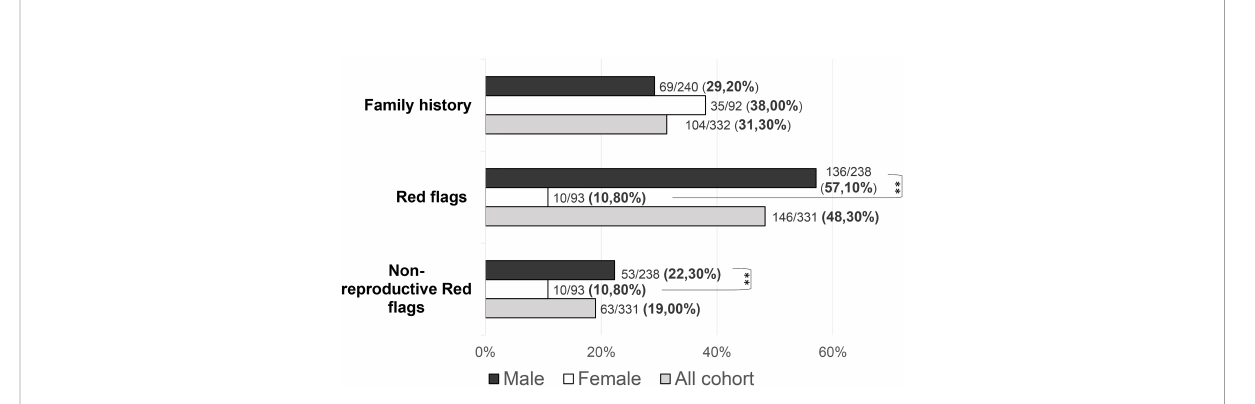
FIGURE 4 Prevalence of “ red fl ags ” and each “ non-reproductive ” defects in the study cohort Red fl ags: cryptorchidism, microphallus, deafness, kidney abnormalities, midline defects and bimanual synkinesis; Non-reproductive red fl ags: deafness, kidney abnormalities, midline defects and bimanual synkinesis. Comparison between male and female patients using Fisher ’ s exact test: ** P =